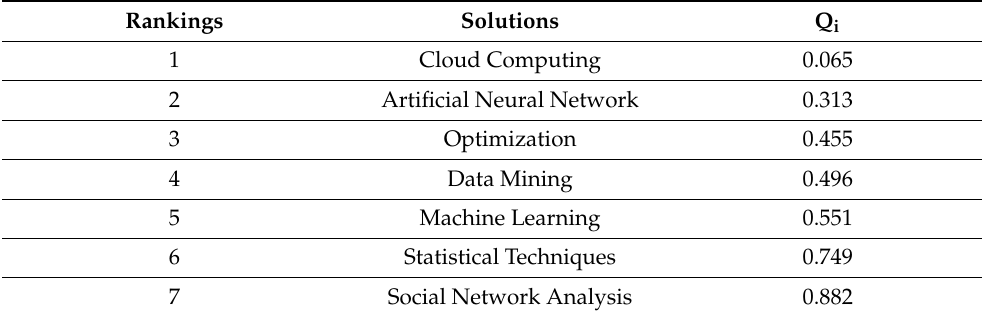
Table 6. Rankings of Big Data